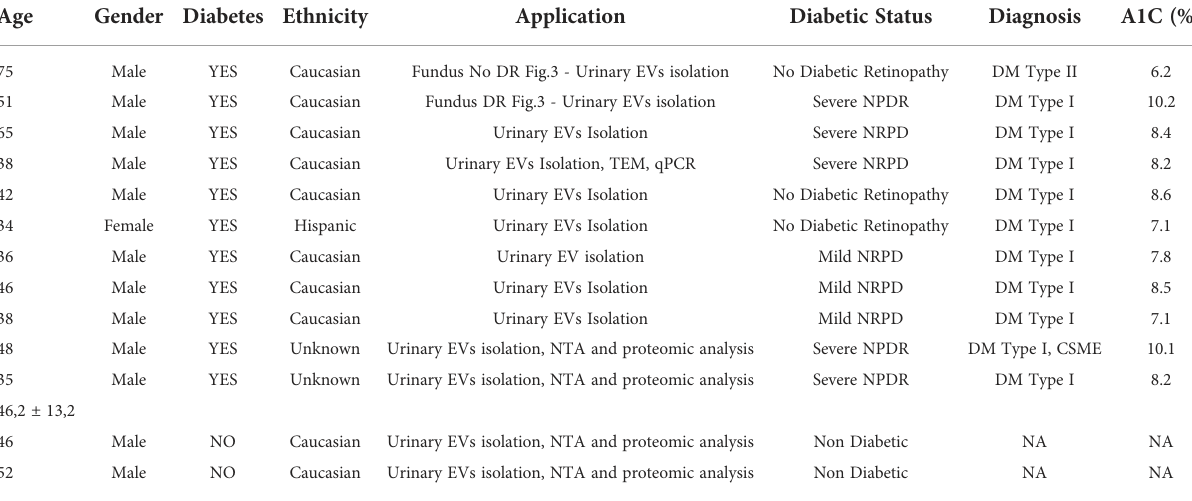
TABLE 2 Human urine patients ’ samples information, including gender, age, diabetes (Yes or No), ethnicity, application of the samples, diabetic status, diagnosis and glycated hemoglobin levels (A1C). Age Gender Diabetes